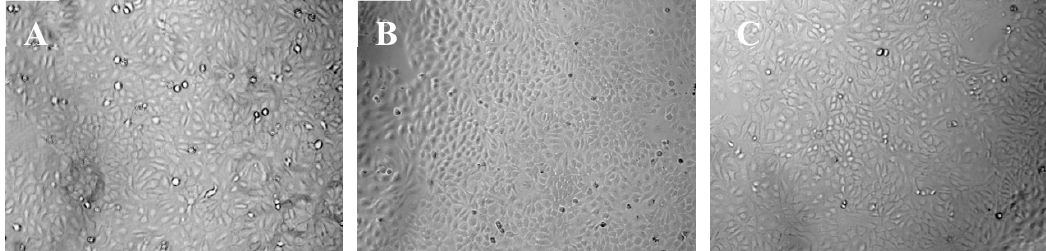
Figure 10. Representative microscopy images of HaCaT cells after 3 days incubation. ( A ): control; ( B ): nanofiber membranes without emodin; ( C ): nanofiber membranes with emodin.